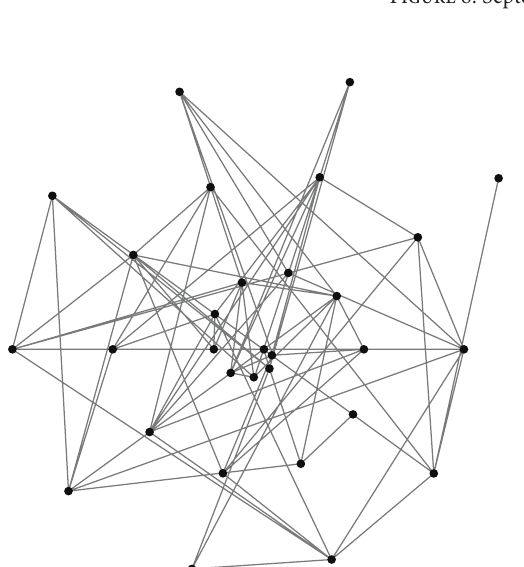
Figure 8: September 11 attackers network.